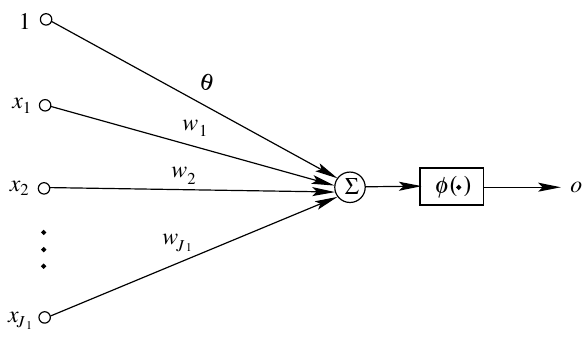
Figure 1. The McCulloch–Pitts neuron